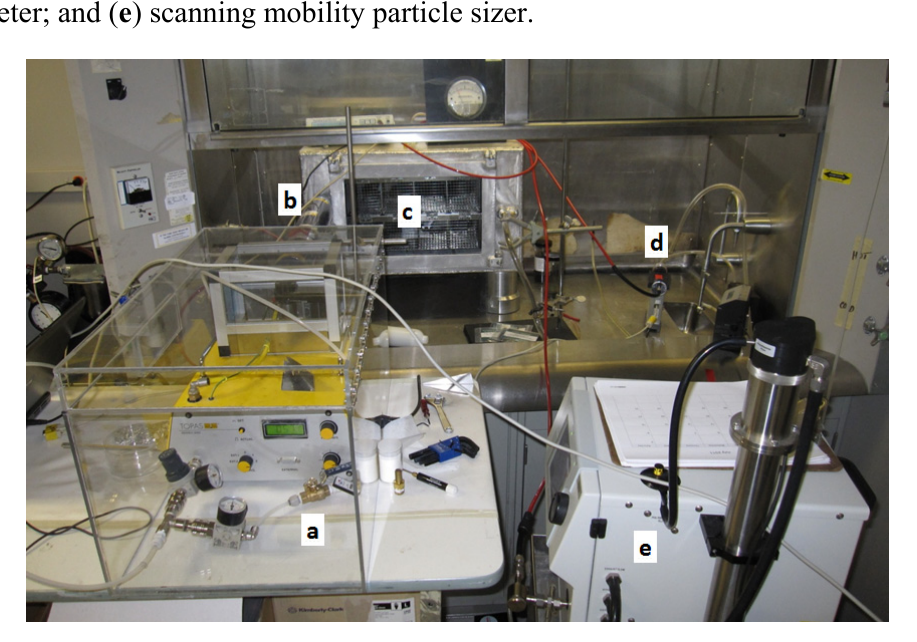
Figure 2. Aerosol delivery system consisting of the ( a ) aerosol generator in an acrylic plastic enclosure; ( b ) charge neutralizer; ( c ) whole body exposure chamber; ( d ) aerosol photometer; and ( e ) scanning mobility particle